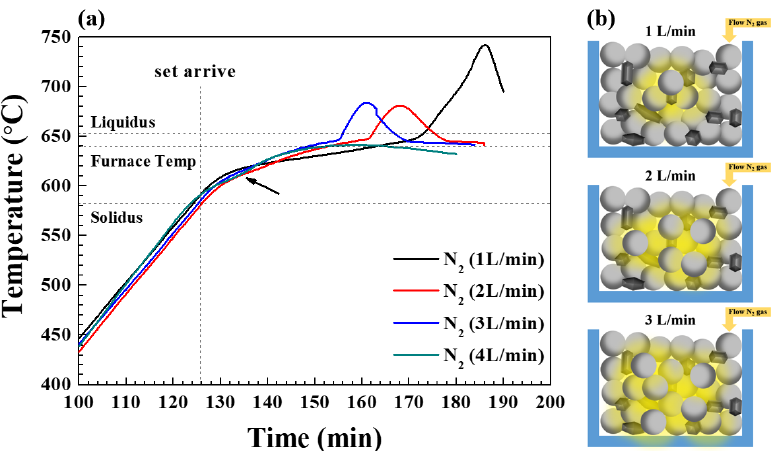
Figure 2. (a) The temperature variation of 20 vol.% SiC (40 μ m)/Al 6061 composites during heating for 1 h at a set temperature of 640 °C under a nitrogen atmosphere at flow rates of 1-4 L/min. (b)